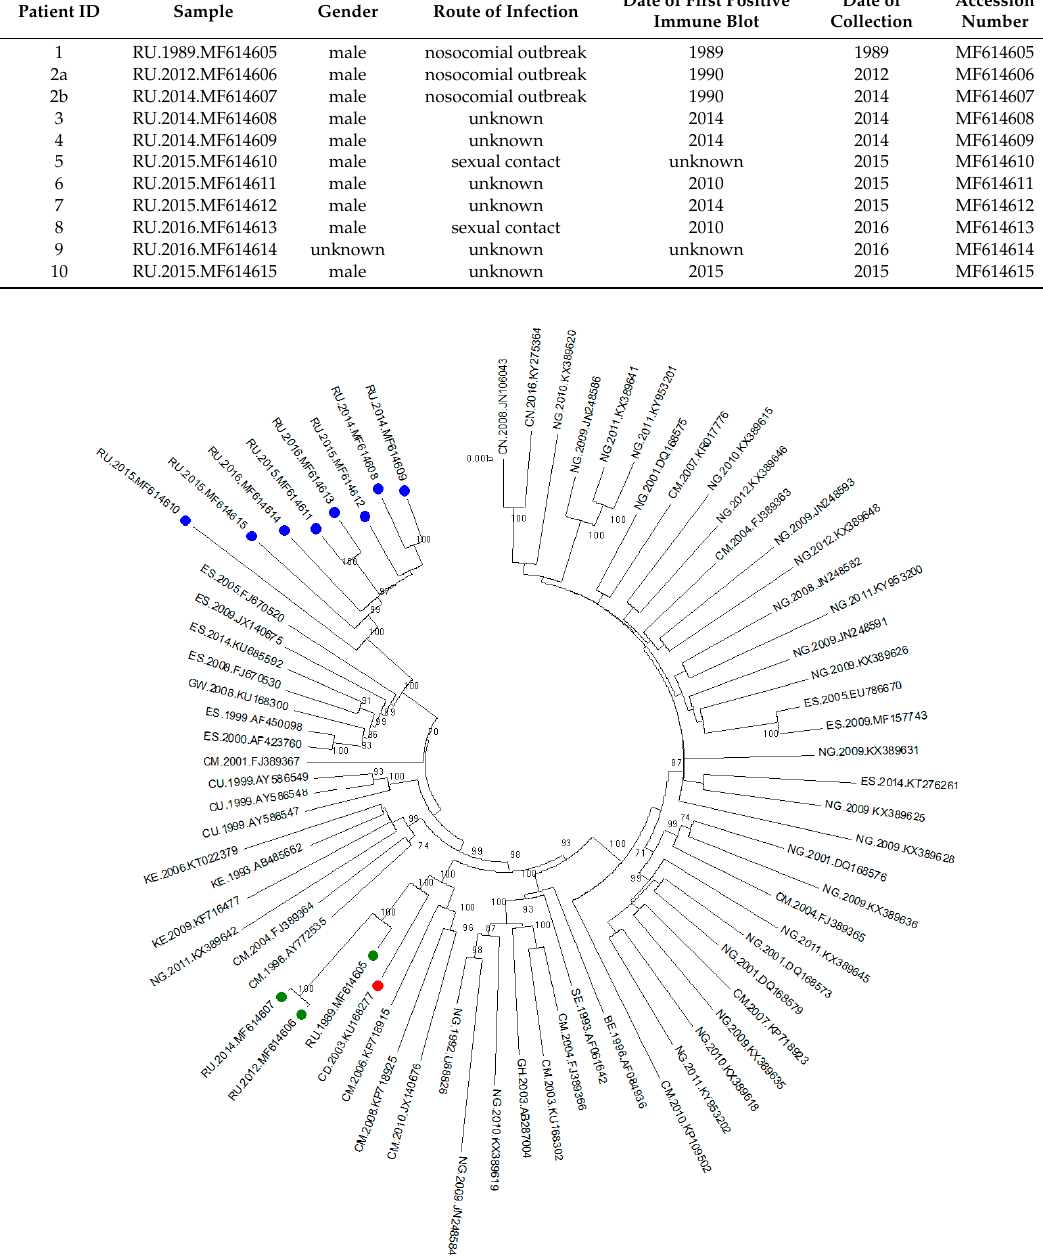
Figure 1. ML tree (500 bootstrap replicates) of HIV-1 subtype G sequences with a length of more than 8000 bp. The green circles indicate the sequences from the patients of the Russian nosocomial outbreak. The red circle indicates the sequence from the Democratic Republic of the Congo. The blue circles indicate the sequences of the infected patients from Russia who were diagnosed after 2010. The name of each sequence combines the country code, sampling year and accession number separated by dots. Only bootstrap values of more than 70% are shown.